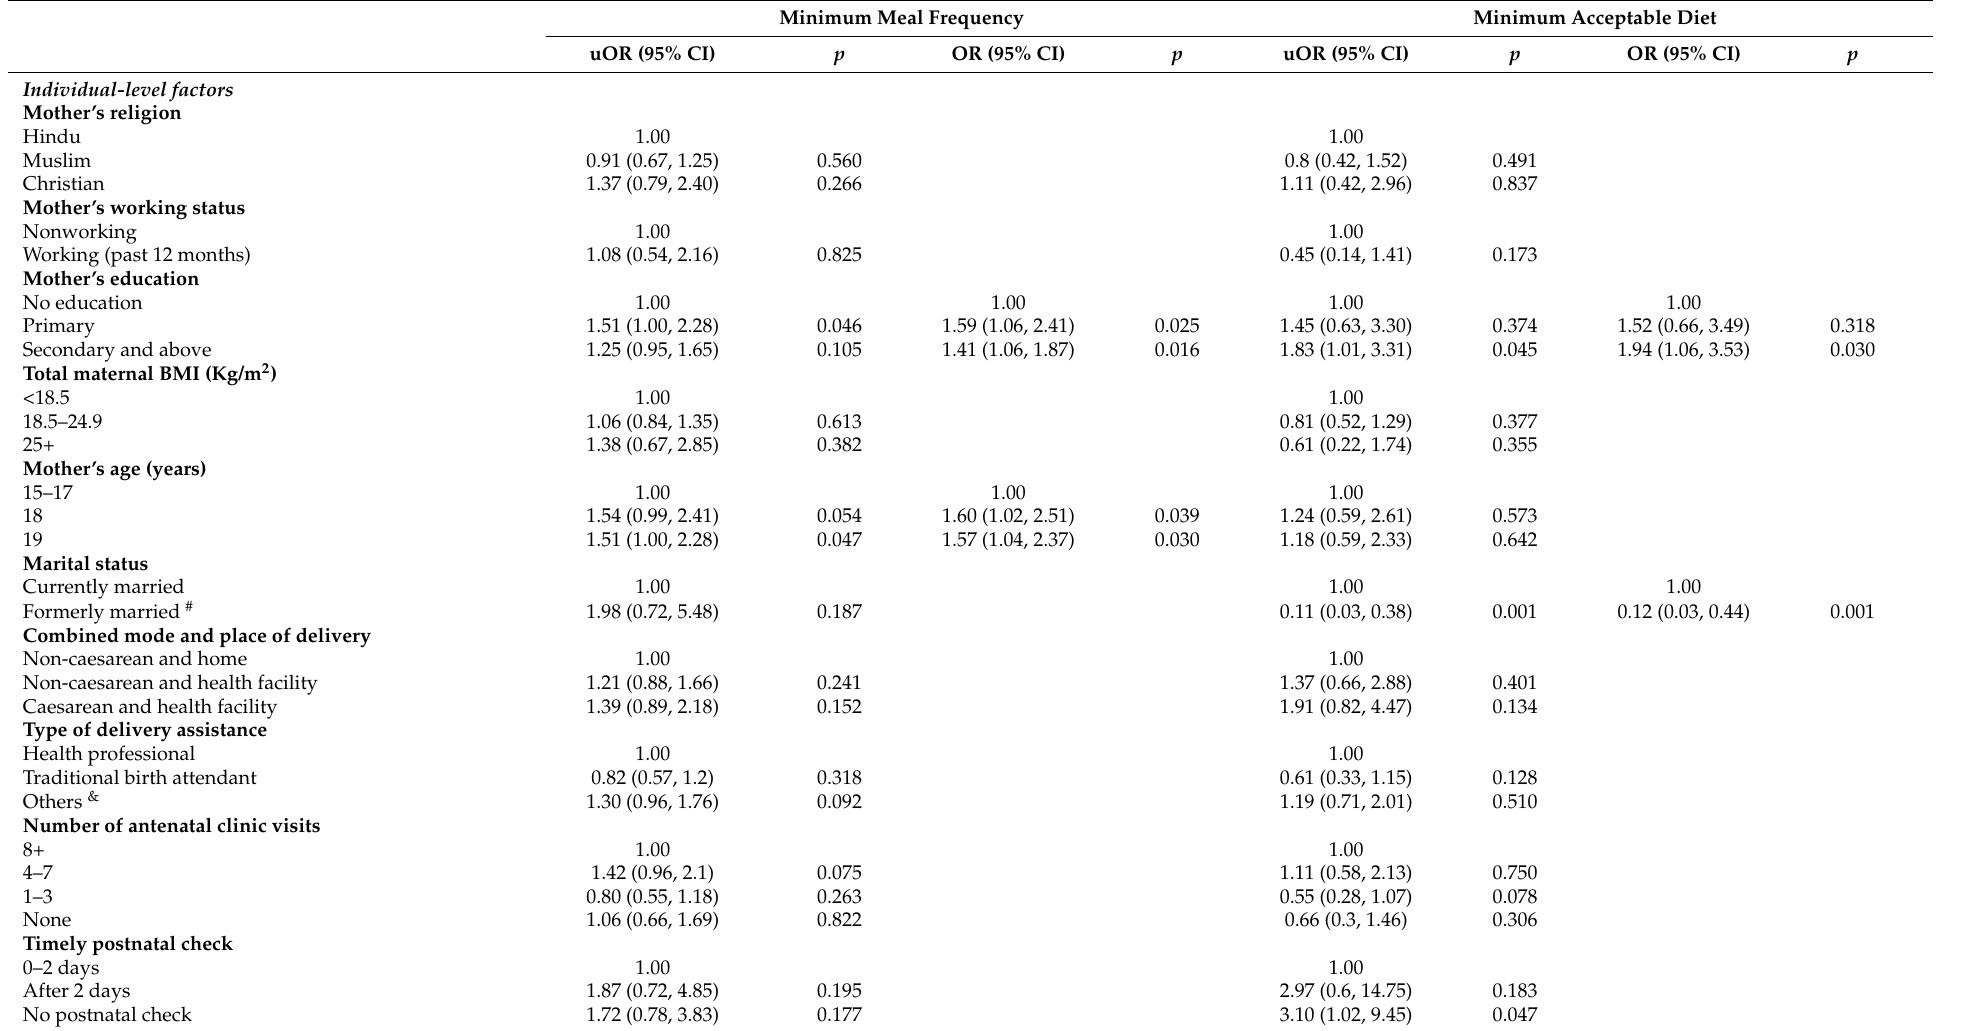
Table 6. Factors associated with minimum meal frequency and minimum acceptable diet in adolescent Indian mothers, 2015–2016